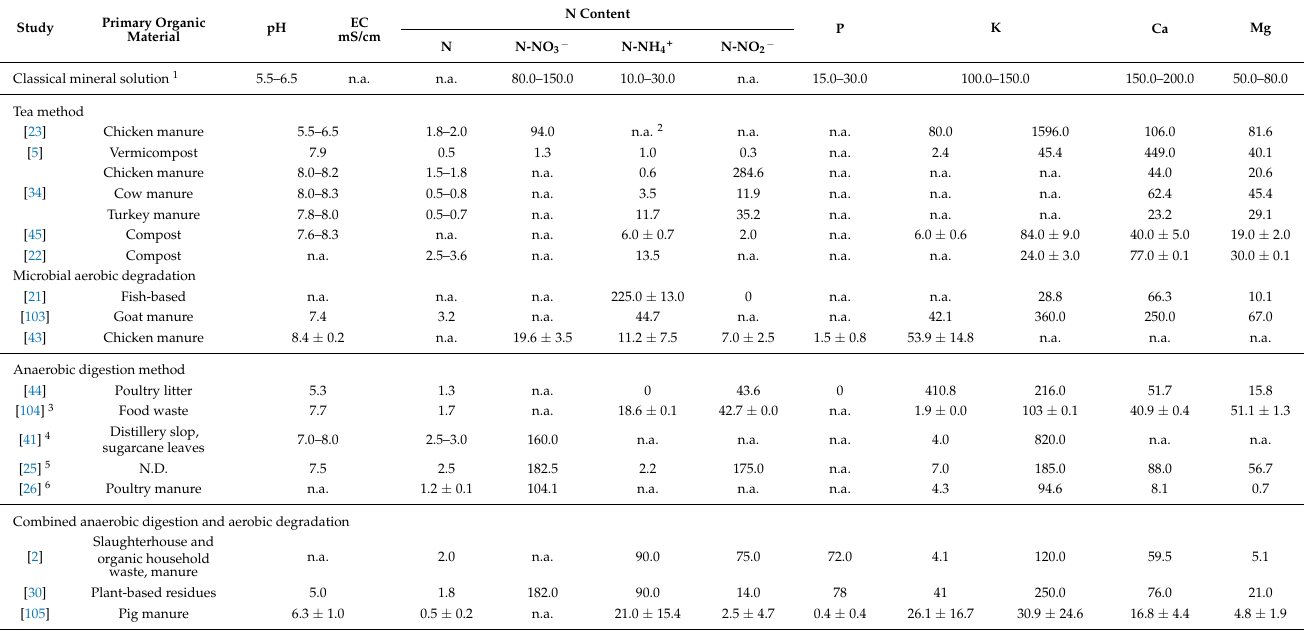
Figure 1. Summary diagram of tea, aerobic microbial degradation, anaerobic digestion and combined anaerobic–aerobic degradation methods for the production of organic nutrient solution. Table 2 presents the composition of the nutrient solutions used on plants and found in the various studies when the data were provided. These solutions are also compared with a “classic” nutrient solution used in conventional hydroponics. Table 2. Chemical and nutrient properties of organic nutrient solutions used on plants (in mg/L). EC, electro-conductivity; N, nitrogen; N-NO 3 − , nitrate-nitrogen, N-NH 4+ , ammonium-nitrogen, N-NO 2 − , nitrite-nitrogen; P, phosphorus; K, potassium; Ca, calcium; Mg,